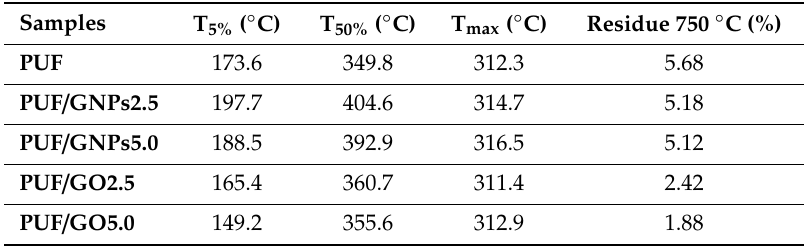
Table 1. Experimental data of TGA